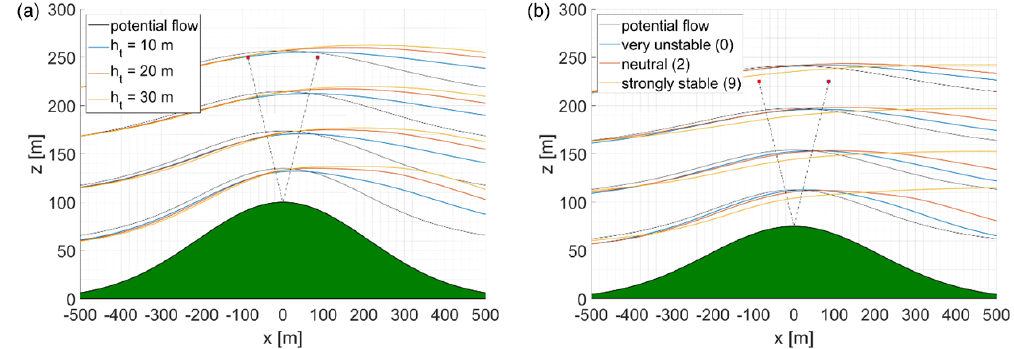
Figure 13. Streamlines in dependence of tree height h t (a) and atmospheric stability class (b) for an H/L ratio of 0.3. Streamlines from Meteodyn WT (coloured) and from the potential flow model (black) are starting at z of 50, 100, 150, and 200m in front of the hill. Lidar measurement points at 150m measurement height with a ϕ of 30 ◦ are marked in